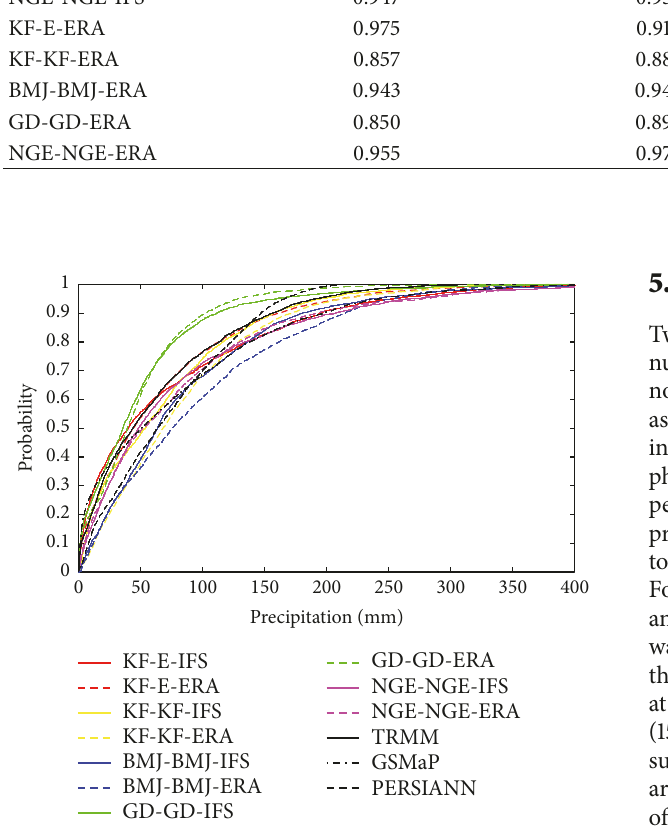
Figure7:Cumulativedistributionfunctionforrainfallfrom00UTC on 4 November to 00UTC on 6 November 2010 for each simulation and observation dataset; only the values within 5 degrees of the approximate storm path centre are